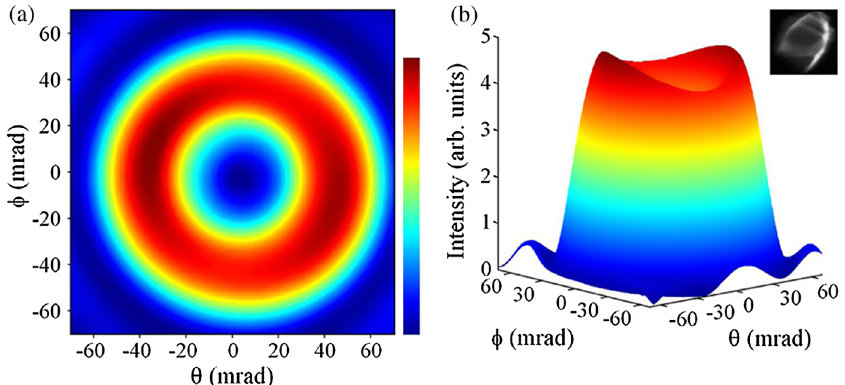
FIG. 3. (a) 2D and (b) 3D plot for the spatial distribution of transition radiation from the electron beam with a transverse distribution at R ¼ 0 : 1 m . The radiation frequency is 1 THz, and the beam image used in the numerical calculation is at the top right